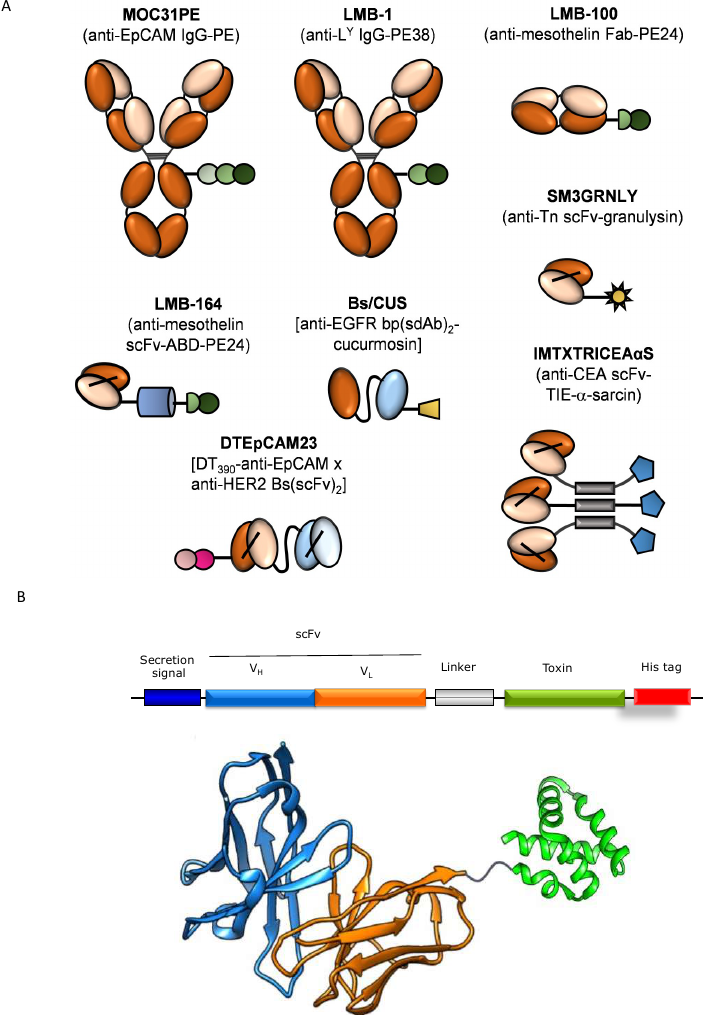
Figure 1. ( A ) Schematic representation of different formats of colorectal cancer-targeted immunotox- ins. ( B ) Design and structure of the anti-CEA, granulysin-based immunotoxin MFE23GRNLY.